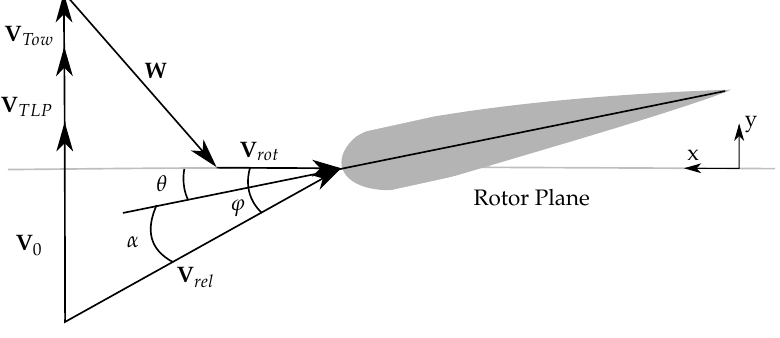
Figure 1. An airfoils velocity triangle for